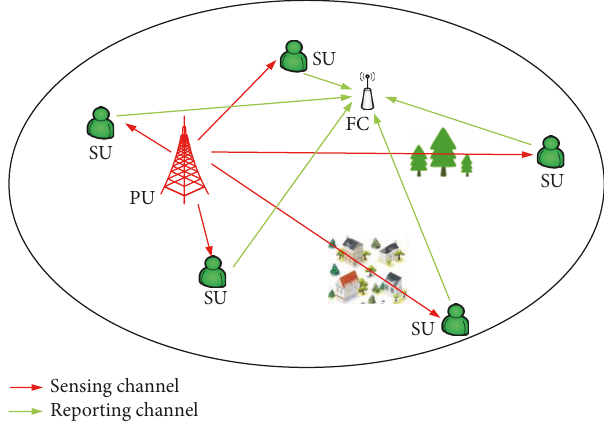
Figure 1: The basic system model of cooperative spectrum sensing.